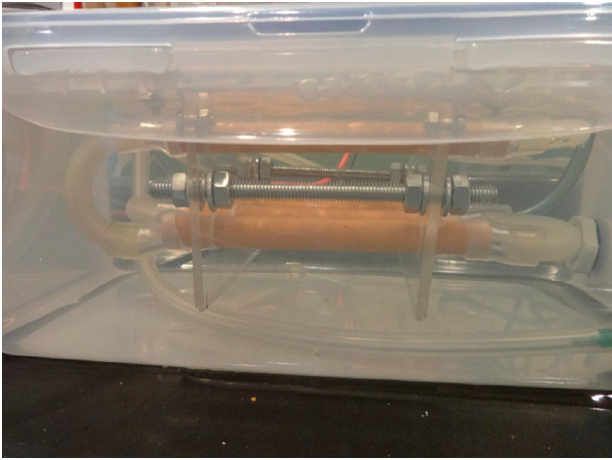
Figure 2. Water cell with hydrophobized porous ceramic tubes immersed in distilled